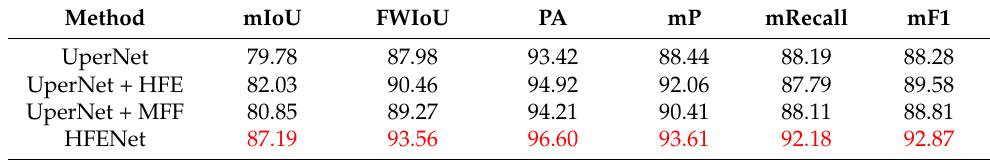
Table 2. The quantitative results of HFE and MMF ablation experiments on the MZData (%).